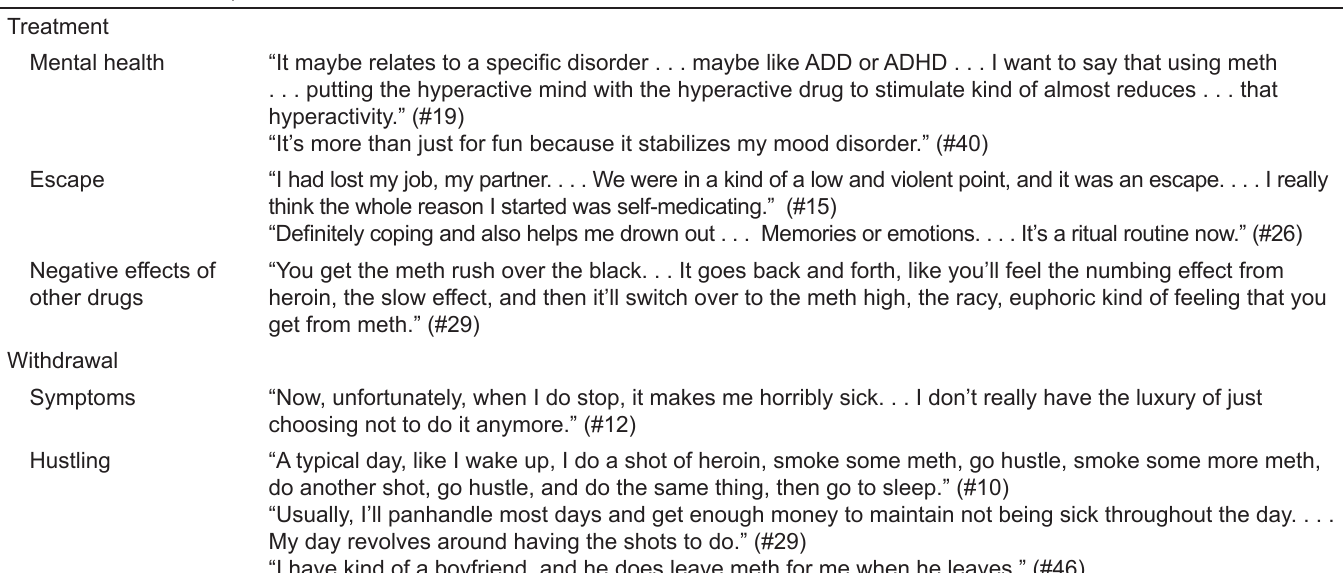
Table 5. Interviewee experiences that describe treatment and withdrawal.